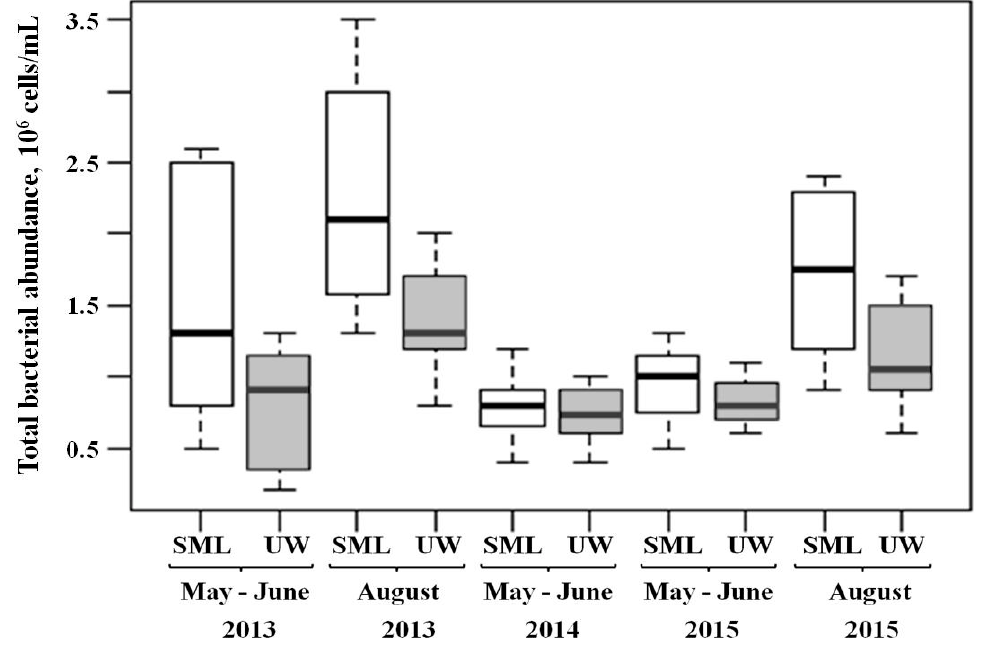
Figure 2. Total bacterial abundance (10 6 cells/mL) in the SML and UW of Lake Baikal in May–June and August of 2013–2015.